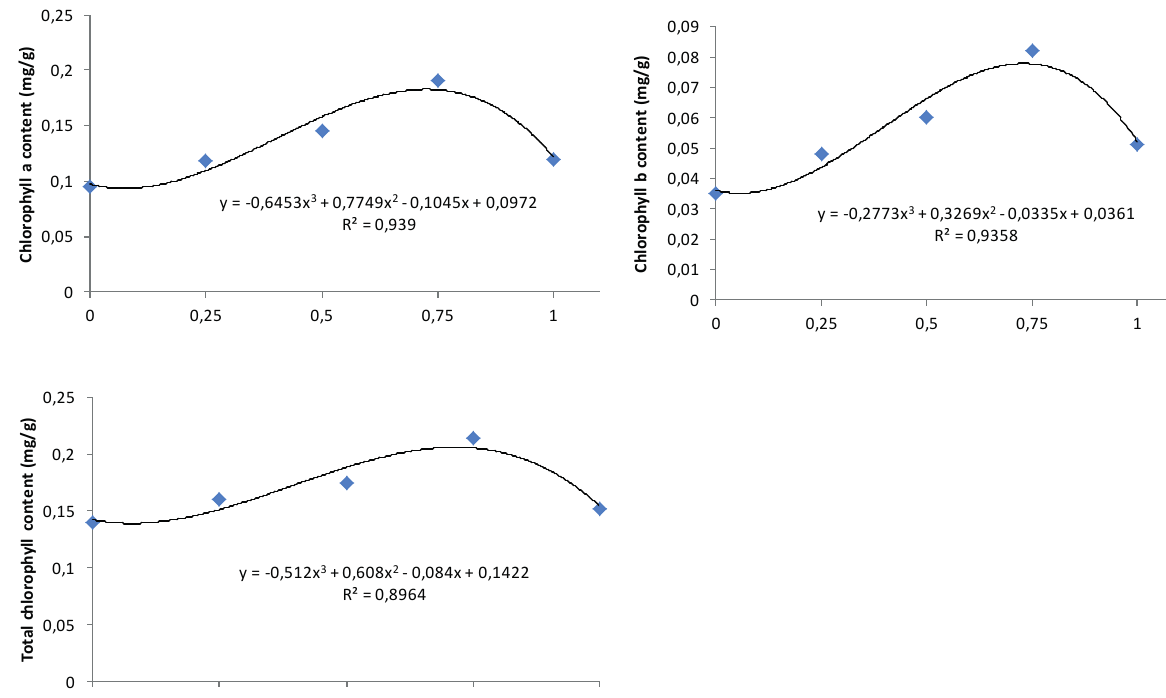
Figure 4 - The effect of different concentrations of nano-iron oxide on soybean seed mineral content.